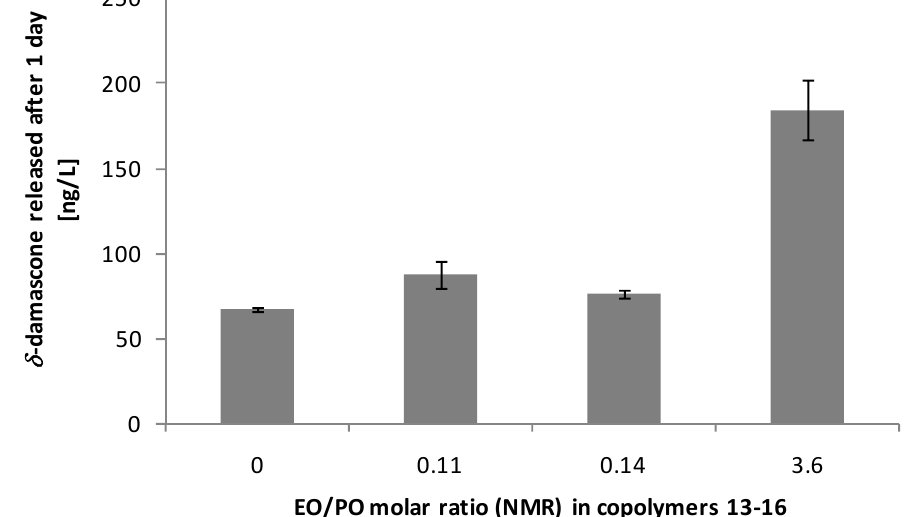
Figure 7. Headspace concentrations of δ -damascone on dry cotton as a function of EO/PO molar ratio in the side chain of conjugates 13 – 16 after line drying for 24 h and sampling for 4